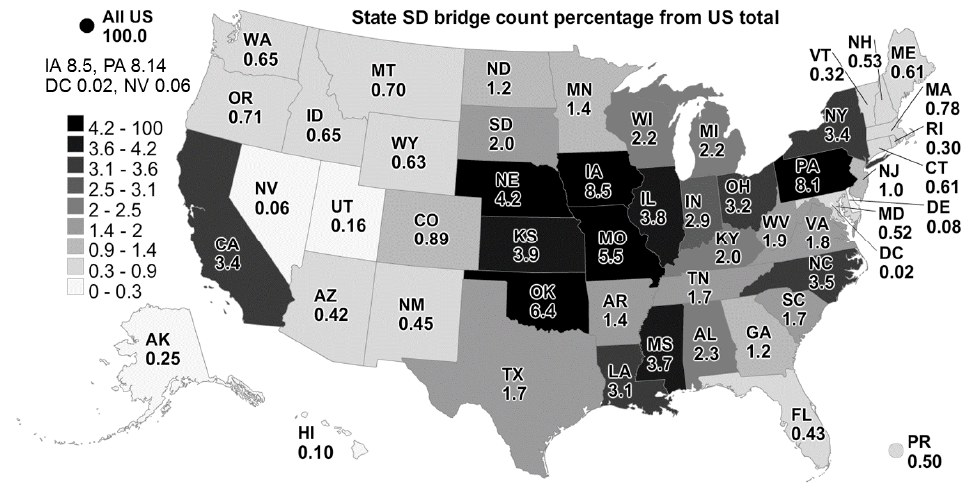
Figure 2. Percentage distribution of state structurally deficient bridge counts from U.S. total.